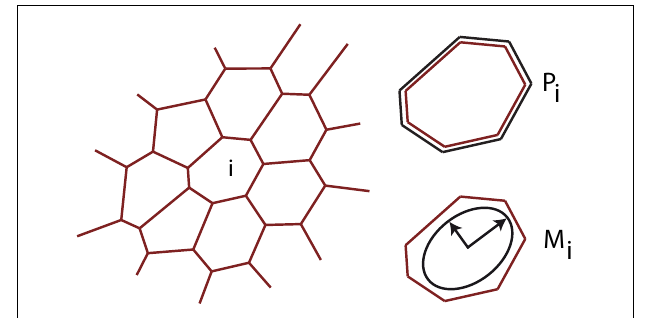
FIGURE 2 | Illustration of the tissue model. The tissue is abstracted to a two dimensional tilling of space by cells, which are defined by straight cell walls intersecting in vertices, where three neighboring cells meet. At each time-point the tissue is in mechanical equilibrium, balancing the forces arising from differential growth. Mechanical forces are captured by an energy functional encompassing the perimeter P i of each individual cell i and an anisotropic form tensor M i , defined as the second moment of area tensor, allowing us to implement anisotropic individual cell expansion.